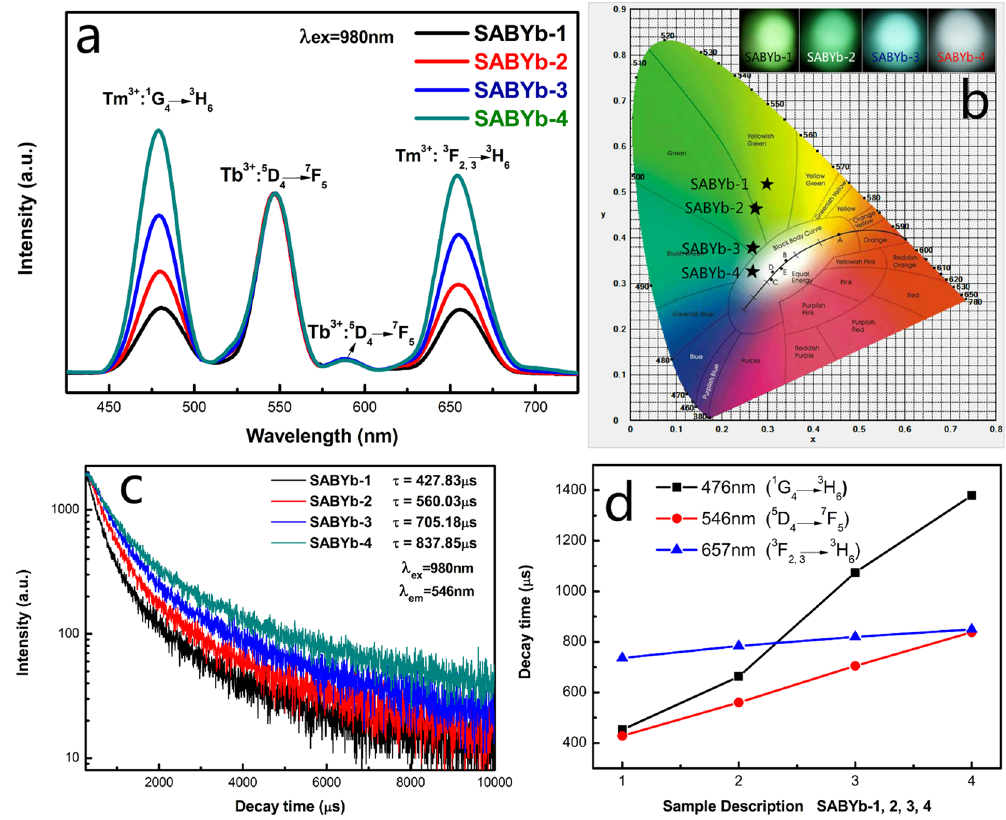
Figure 4. ( a ) The UEC emission spectra of SABYb-1, SABYb-2, SABYb-3 and SABYb-4 glass-ceramics. ( b ) CIE (X, Y) coordinate diagram showing chromaticity points of Tb 3 + and Tm 3 + luminescence in the nanocomposites. ( c ) Fluorescence decay curves of Tb 3 + ions at 546 nm in the SABYb glass-ceramics. ( d ) Decay behavior of 5 D 4 , 1 G 3 F 4 and 2,3 levels for the SABYb glass-ceramics under 980 nm